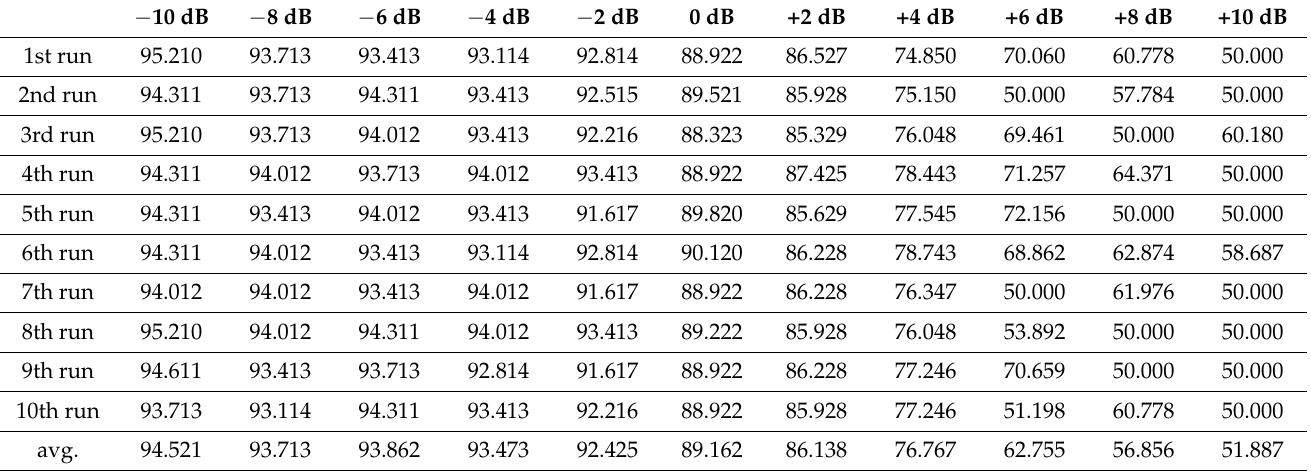
Table 4. Obtained classification accuracies [%] for datasets of spectrogram